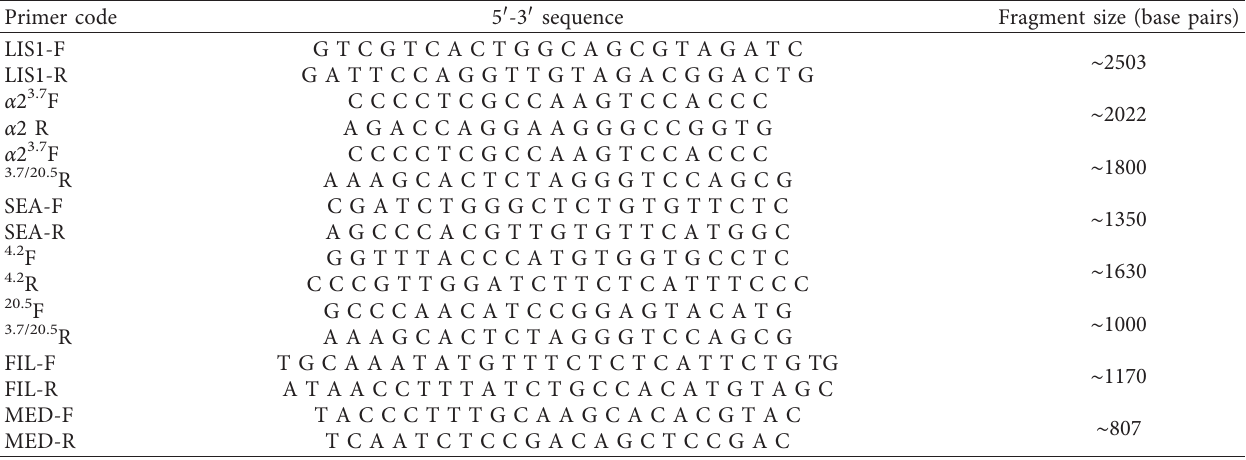
Table 1: Primers used for detection of common deletional determinants of alpha-thalassemia. Primer code